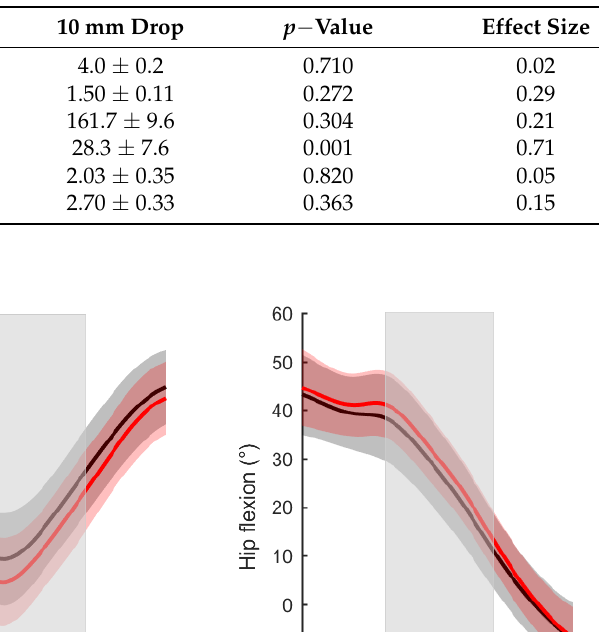
Table 1. Comparison of gait parameters and peak impact forces between flat shoes and conventional shoes with a 10 mm drop.